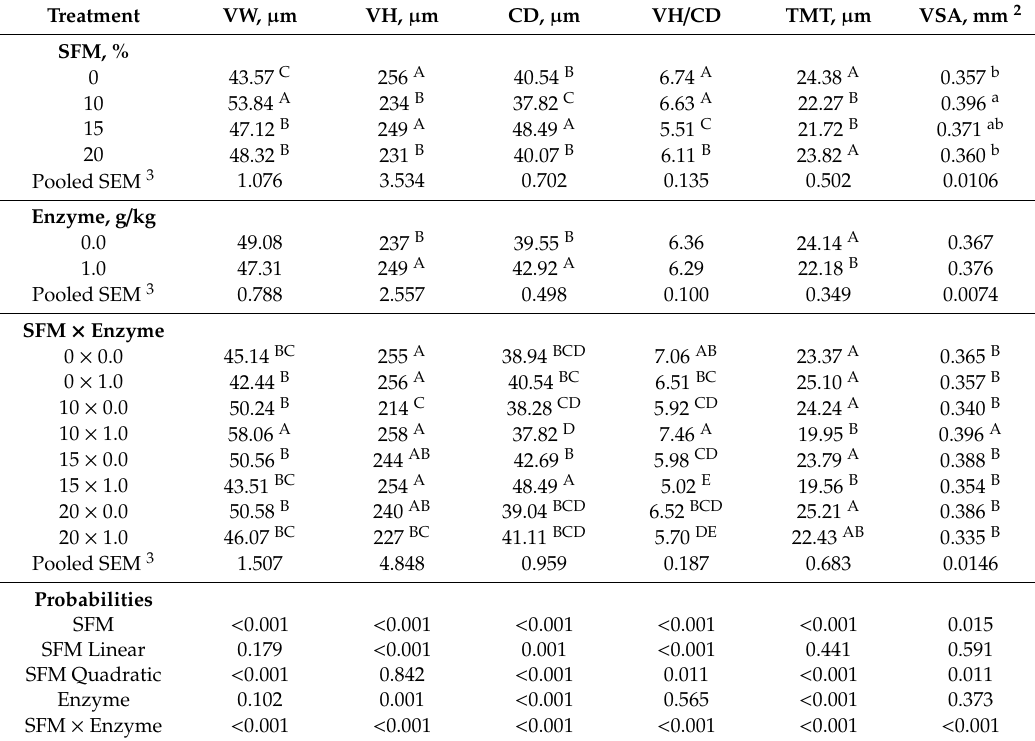
Table 4. Influence of SFM and multi-enzyme supplementation in diets on the histomorphology parameters of ileum in growing quails